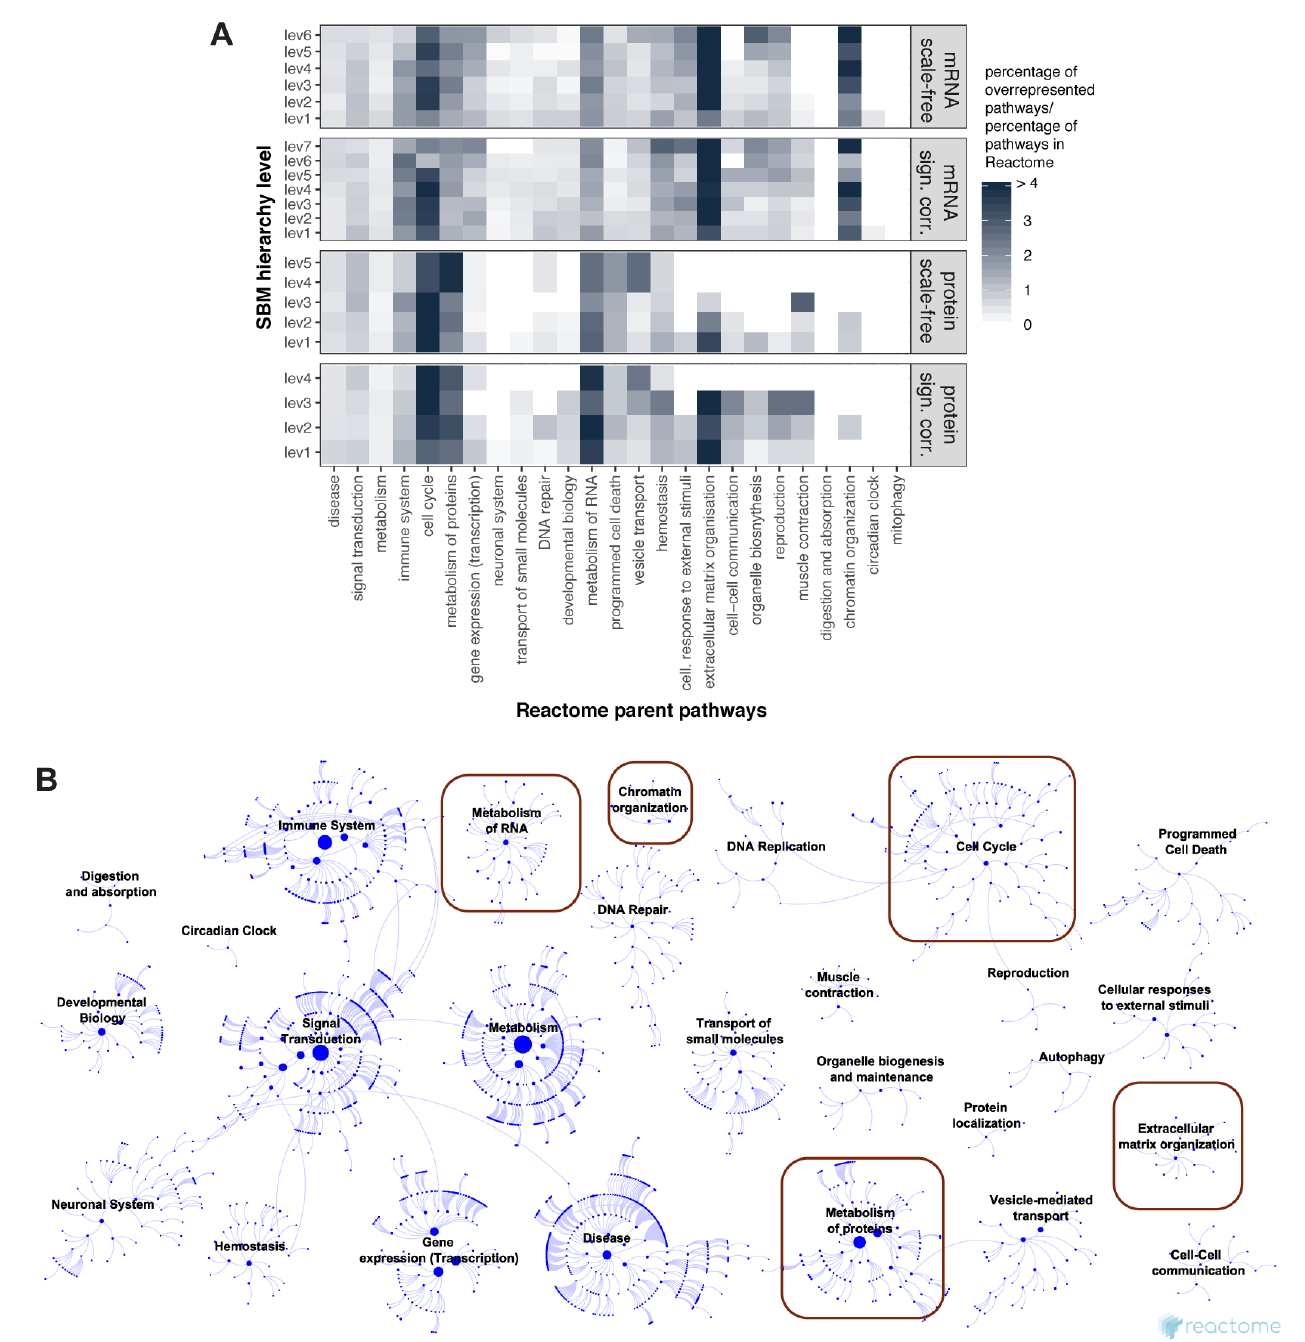
Figure 5. SBM-derived blocks of mRNA and protein networks predict further pathways relevant for breast cancer. ( A ) We mapped the Reactome pathways to their Reactome parent pathways and counted their occurrence as overrepresented pathway in SBM-derived blocks of the four mRNA and protein networks and each hierarchy level. Reactome parent pathways are sorted by the number of pathways they summarize (see ( B )). The color code gives the percentage of occurrence as overrepresented of each parent pathway (counted occurrence divided by total number of overrepresented pathways obtained for the SBM-clustering of the hierarchy level and network) relative to the percentage of each parent pathway in the Reactome annotation (number of pathways associated to the parent pathway relative to the number of total Reactome pathways). These values indicate whether certain parent pathways occur more frequently than suggested by the size of the parent pathways cluster in Reactome. The higher the value (i.e. the darker the color), the more relevant the parent pathway is predicted by the SBM-derived network structure. ( B ) Reactome pathway organization (downloaded from the Reactome website Pathway Viewer, 39). The parent pathways that are predicted as especially relevant for breast cancer according to ( A ) are highlighted.